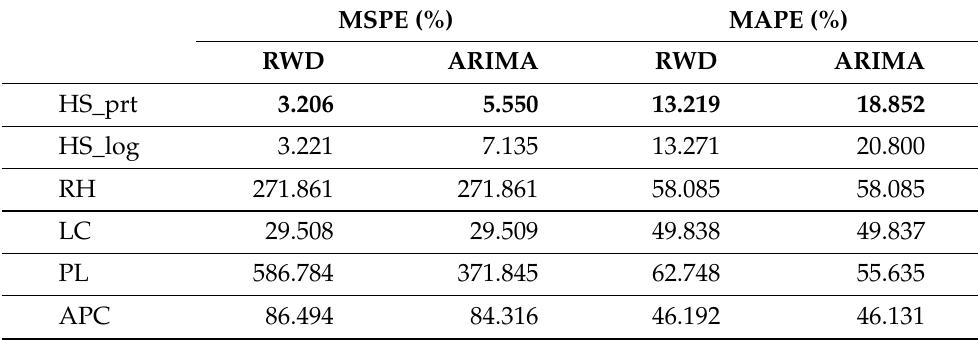
Table 9. Results of the percentage error tests for predicted mortality rates of 10 years out-of-sample for well-known stochastic mortality models against HS_prt for E&W dataset.